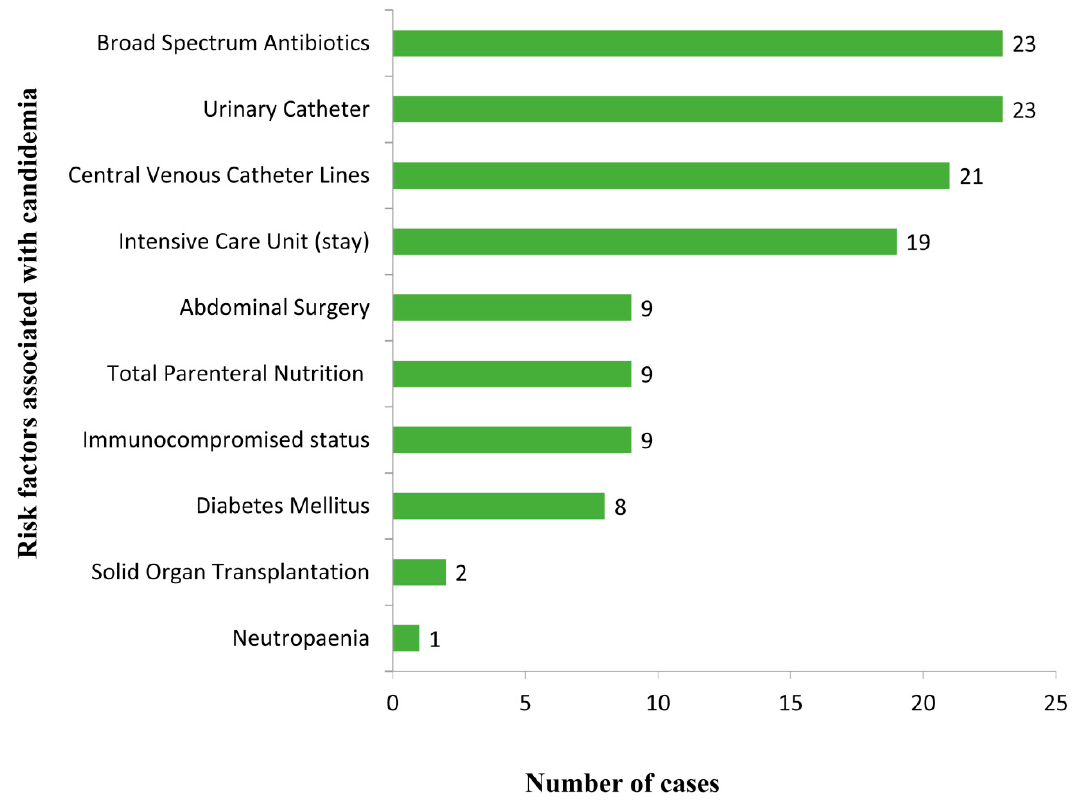
Figure 1. Risk factors for Candida auris infections in hospitalized patients ( n = 23).